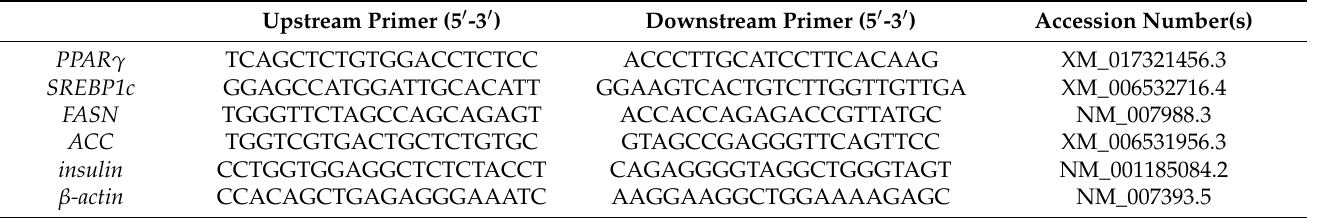
Table 1. List and sequences of primers used in the RT-PCR experiments. Upstream Primer (5 (cid:48) -3 (cid:48)